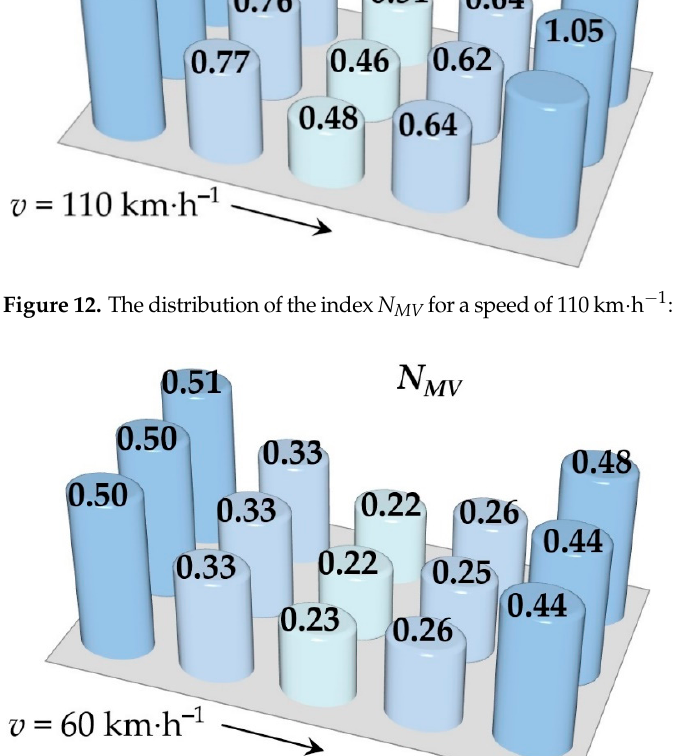
Sensors 2021 , 21 , x FOR PEER REVIEW 17 of 21 Figure 13. The distribution of the index N MV for a speed of 60 km · h − 1 : the “Modification II” parameters.